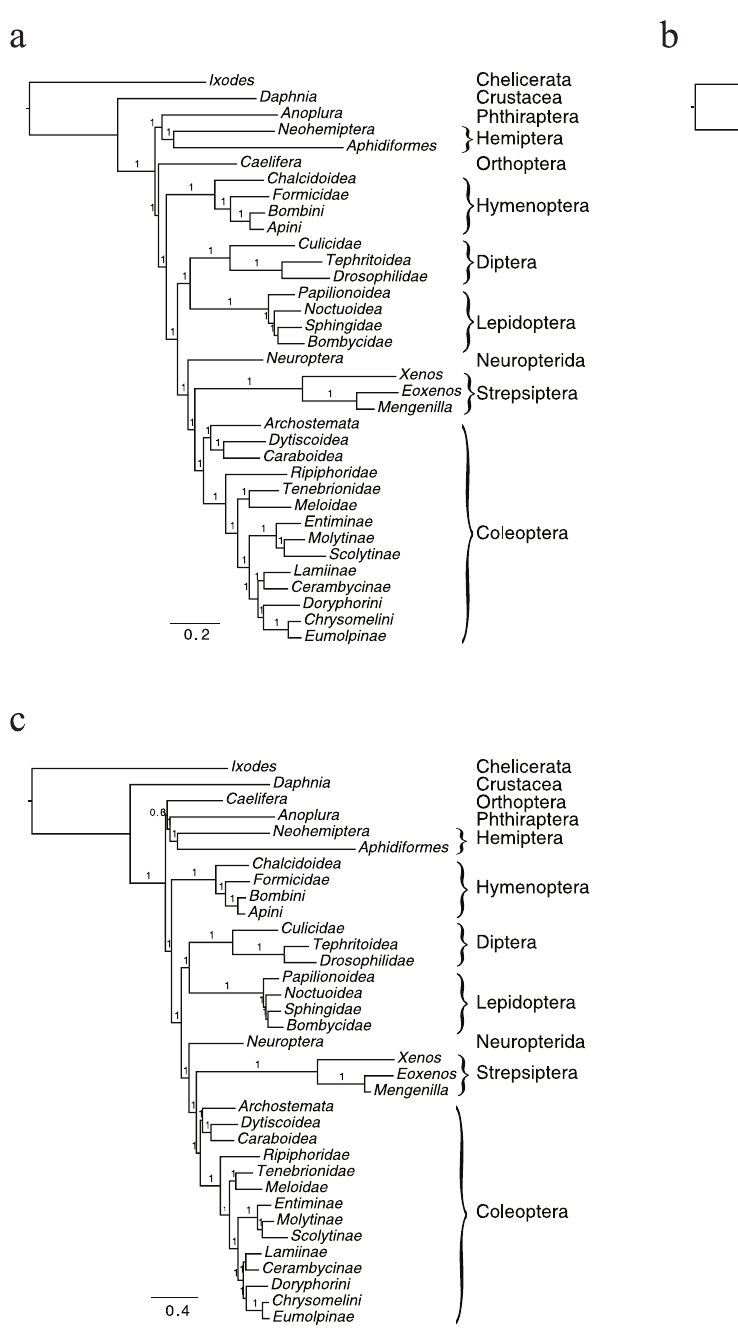
Figure 3. Phylogenetic trees reconstructed using GTR + C (a), CAT + C (b) or CATGTR + C (c).